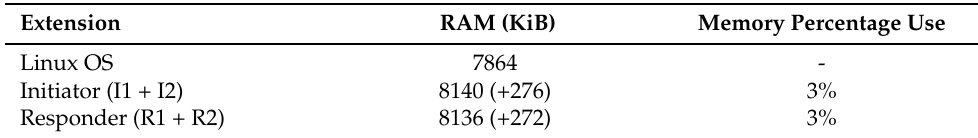
Table 15. Memory consumption of LC-DEX